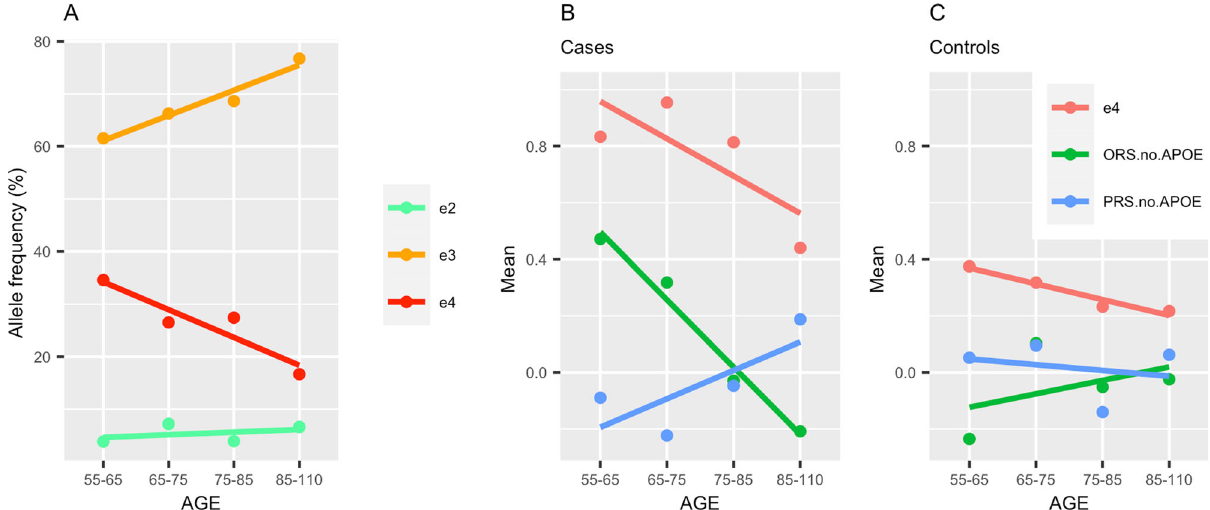
Fig. 1 Effects of APOE allele frequencies and age on genetic risk scores. A Allele ε 4, ε 3, ε 2 frequencies (red, orange and green lines respectively) in the case-control dataset (271 cases and 278 controls), B , C the mean risk score for ε 4 allele frequencies, ORS.no.APOE and PRS.no.APOE (red, green and blue lines respectively) split by age groups. ORS.no.APOE includes SNPs with p -value ≤ 1e-5, PRS.no.APOE includes SNPs with p -value ≤ 0.1 and both exclude the APOE region. A represents the full sample ( B ) represents cases only and ( C ) controls only. Age groups are speci fi ed as (55 – 65, 65 – 75, 75 – 85, 85 + ). For comparability of the scores in ( B , C ) the e4 genotypes (originally coded as 0/1/2) were also standardised. ORS Oligogenic risk score, PRS Polygenic risk score, SNP Single nucleotide